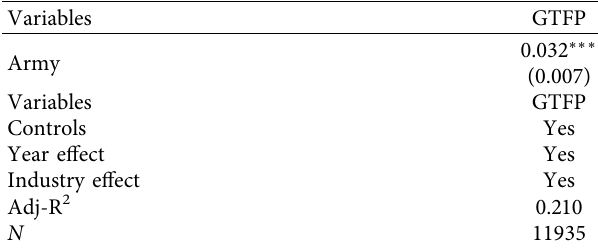
Table 4: Replacement of explained variable.